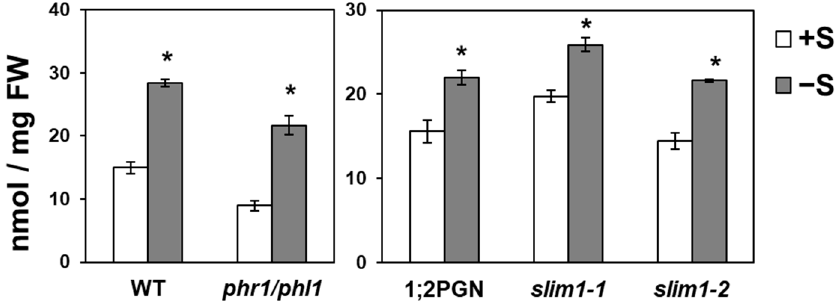
Figure 6. E ff ects of SLIM1 and PHR1 / PHL1 disruption on –S-increased Pi accumulation in shoots. Plant growth and Pi analysis were performed as described in Figure 1. 1;2PGN represents P SULTR1;2 -GFP , the parental line of slim1 mutants [44,49]. Bars and error bars indicate mean ± SE ( n = 4). Asterisks indicate significant di ff erences between + S and –S detected using Student’s t -test (* p <